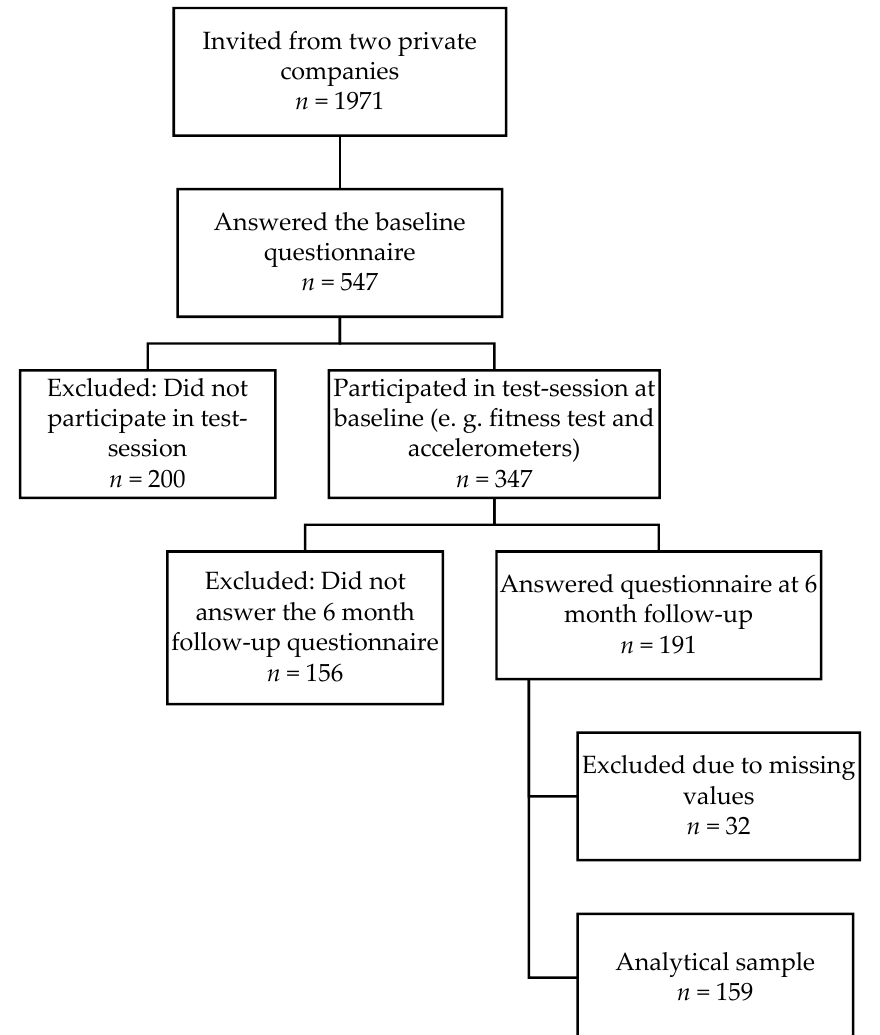
Figure 1. Flowchart illustrating how the analytical sample was reached from the invited individuals.